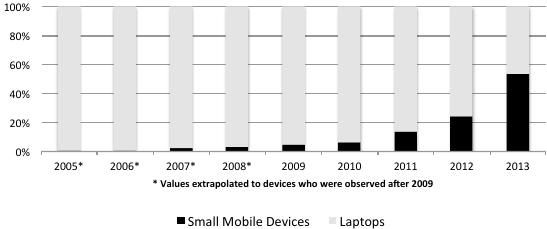
Figure 3: Proportion of Laptops to Small Mobile Devices observed